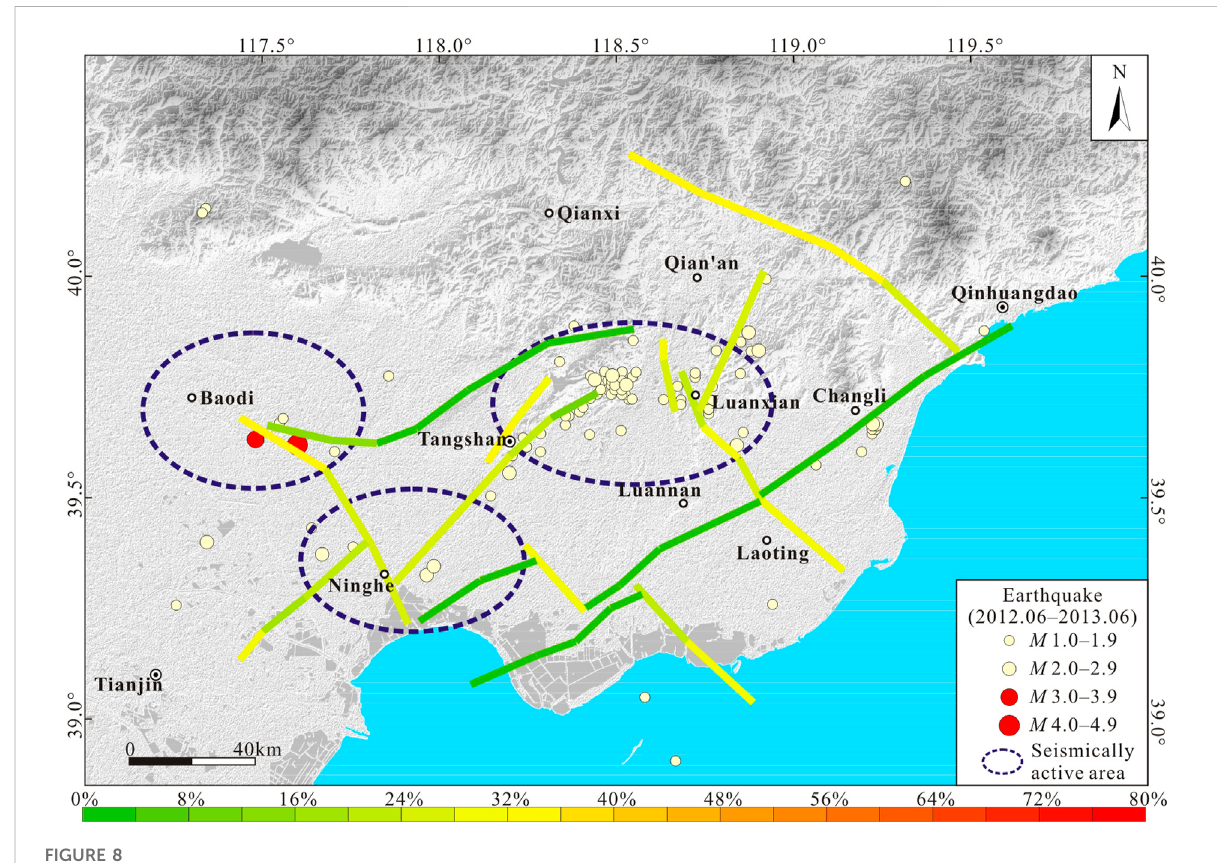
FIGURE 8 The fault slip potential on the main faults in Tangshan seismic region in stage